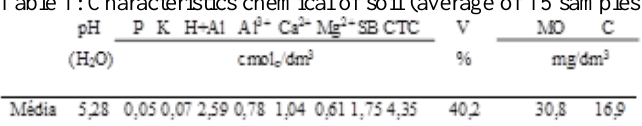
Table 1: Characteristics chemical of soil (average of 15